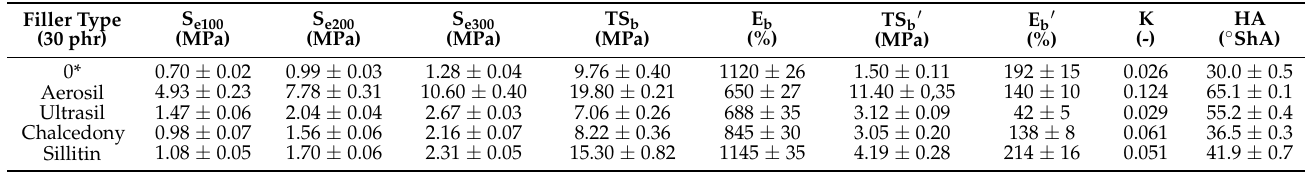
Table 7. Selected properties of unfilled and filled CR/BR/nano-Fe 2 O 3